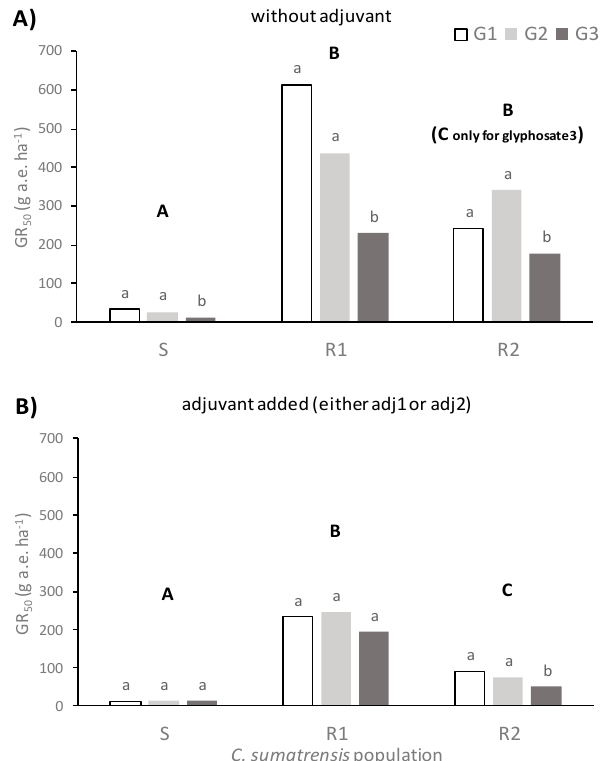
Figure 2. E ff ects of C. sumatrensis population, glyphosate formulation and adjuvant addition on GR 50 values according to the minimal adequate non-linear mixed-e ff ects model based on a log-logistic dose–response curve with no adjuvant added ( A ) and after addition of adjuvant ( B ), either adj1 or adj2. Adjuvant addition significantly reduced GR 50 values for every population and glyphosate formulation. For each panel and population, GR 50 values for the glyphosate formulations with the same lower-case letter did not di ff er statistically. Di ff erent upper-case letters within each panel indicate significant di ff erences among